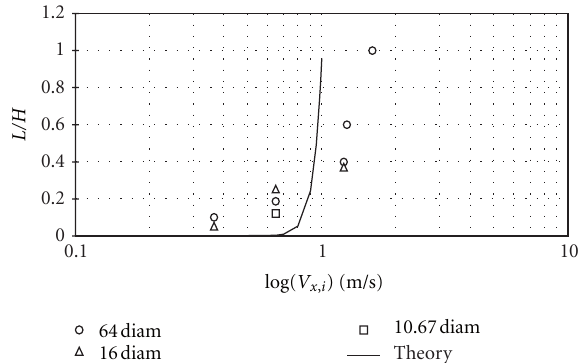
Figure 20: Lift-o ff height for 85% N 2 and 13% C 3 H 8